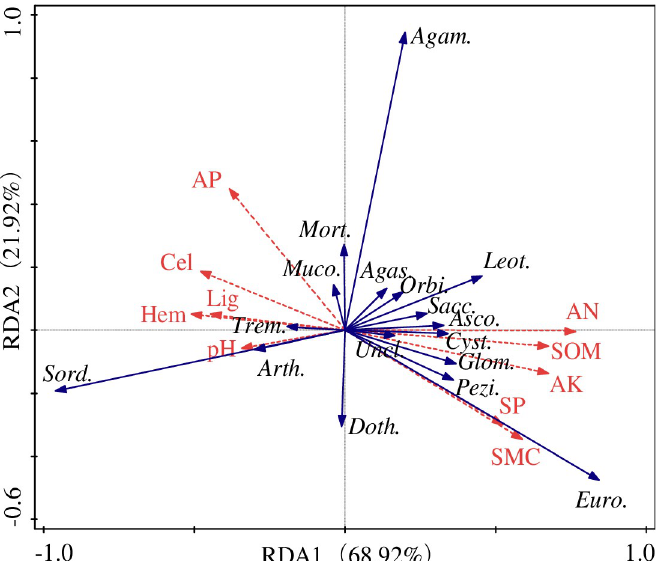
Fig 7. RDA analysis of microenvironmental factors and fungal communities of S . psammophila sand barriers. Cel: Cellulose; Hem: Hemicellulose; Lig: Lignin; AP: Available phosphorus; AK: Available potassium; AN: Available nitrogen; SOM: Soil organic matter; SMC: Soil moisture content; SP: Soil porosity; Sord.: Sordariomycetes; Euro.: Eurotiomycetes; Agam.: Agaricomycetes; Leot.: Leotiomycetes; Asco.: Ascomycetes; Doth.: Dothideomycetes; Mort.: Mortierellomycetes; Agas.: Agaricostilbomycetes; Uncl.: Unclassified; Glom.: Glomeromycetes; Orbi.: Orbiliomycetes; Trem.: Tremellomycetes; Arth.: Arthoniomycetes; Pezi.: Pezizomycetes; Cyst.: Cystobasidiomycetes; Sacc.: Saccharomycetes; Muco.: